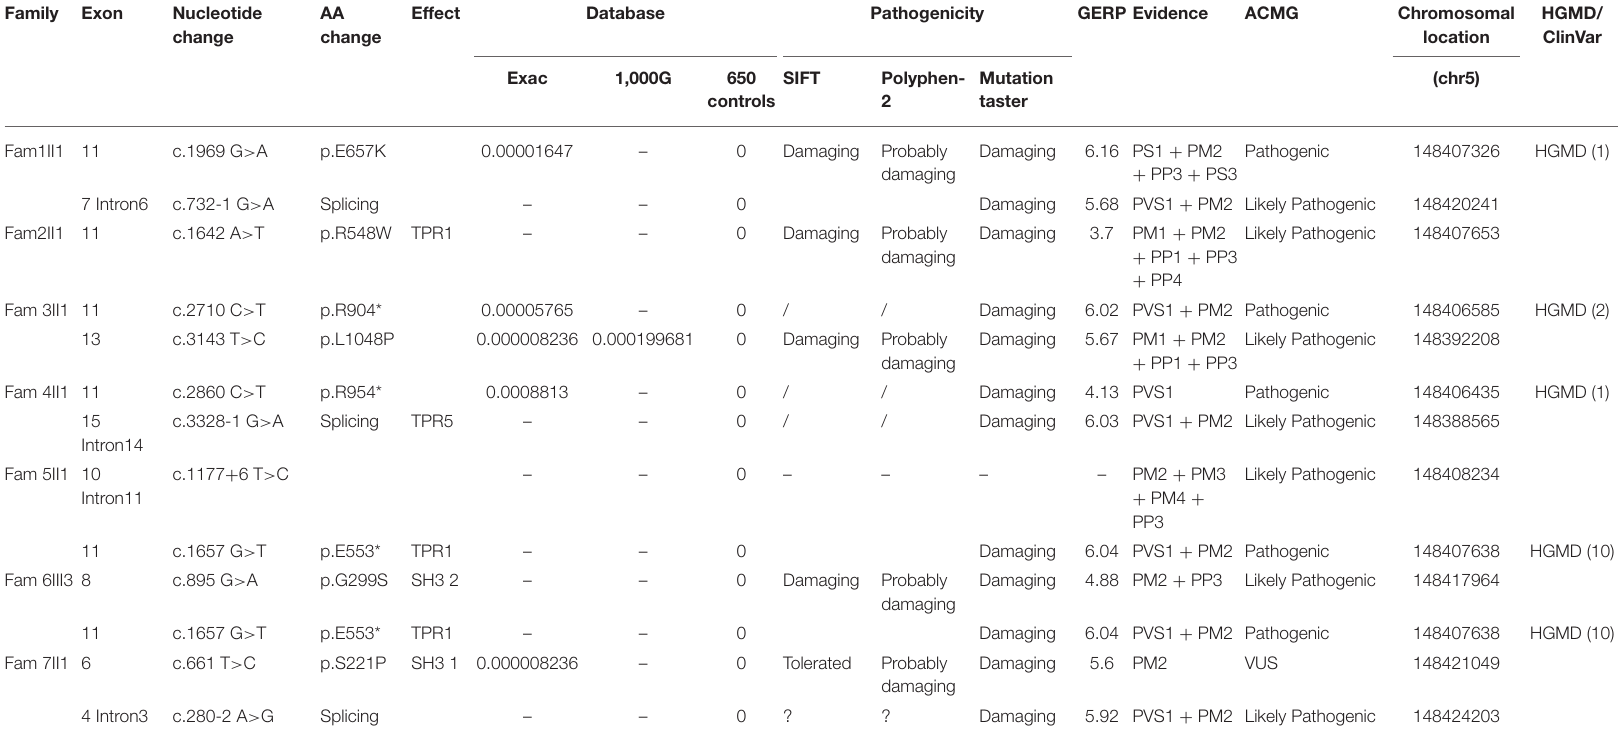
TABLE 3 | Molecular analysis results and predicted pathogenicities of the variants in this study. Family